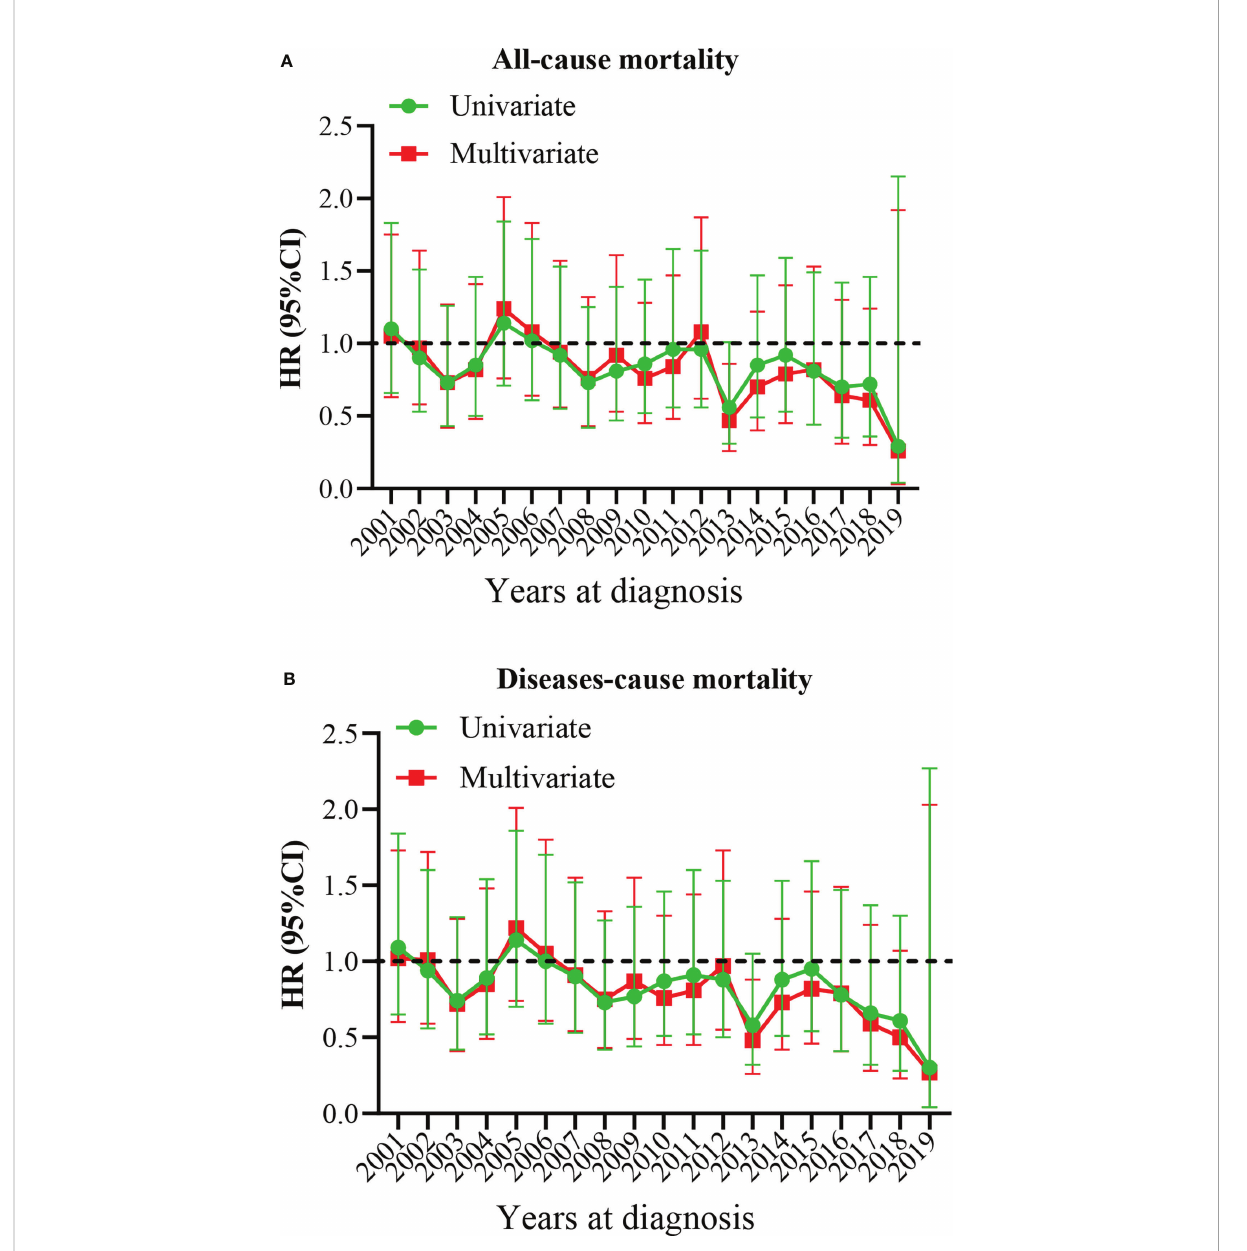
FIGURE 4 Multivariate hazard ratio (HR) analysis for all-cause mortality and diseases-cause mortality. (A) All-cause mortality. (B) Diseases-cause mortality. The year 2000 at diagnosis was considered as a